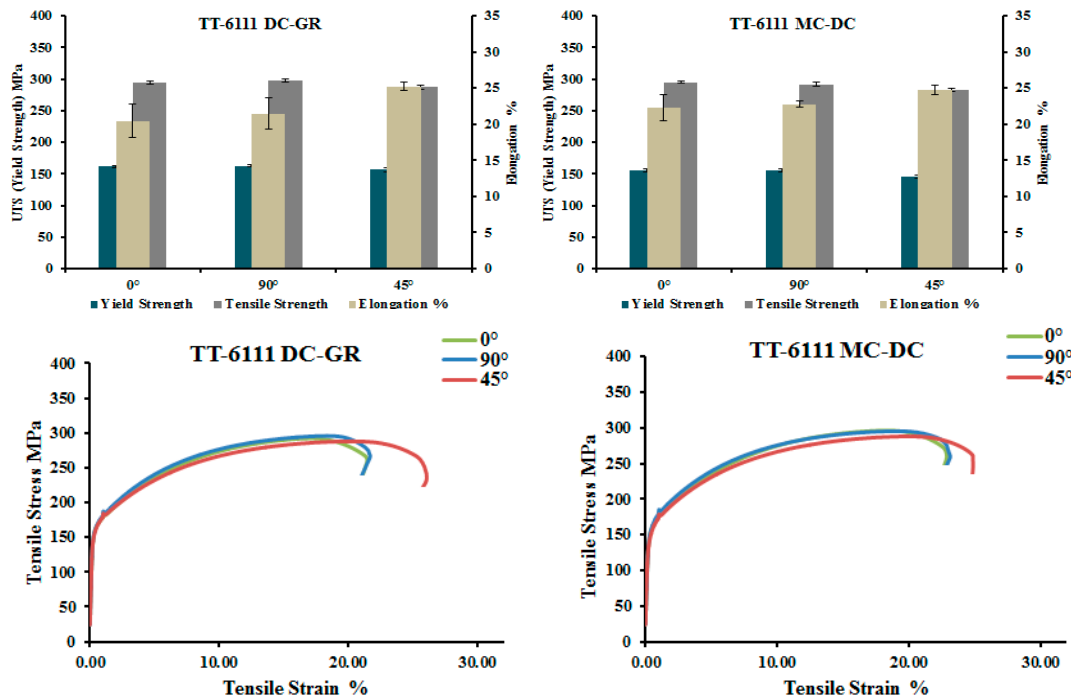
Figure 8. The tensile properties of as-cast TT-6111 (2) planks extruded from homogenized DC-GR and MC-DC cast billets in different orientations.